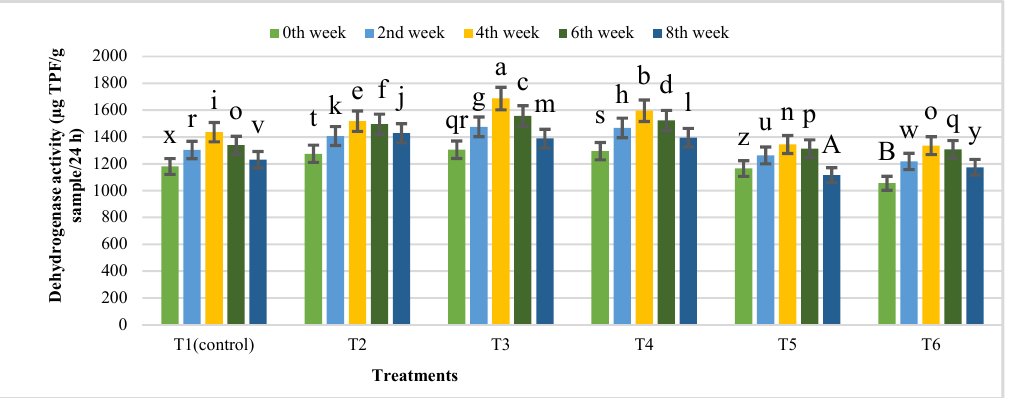
Figure 13. Dehydrogenase activity of different treatments of IONPs during the anaerobic digestion of cattle manure after eight weeks. Bars with different letters depict significantly different values at p ≤